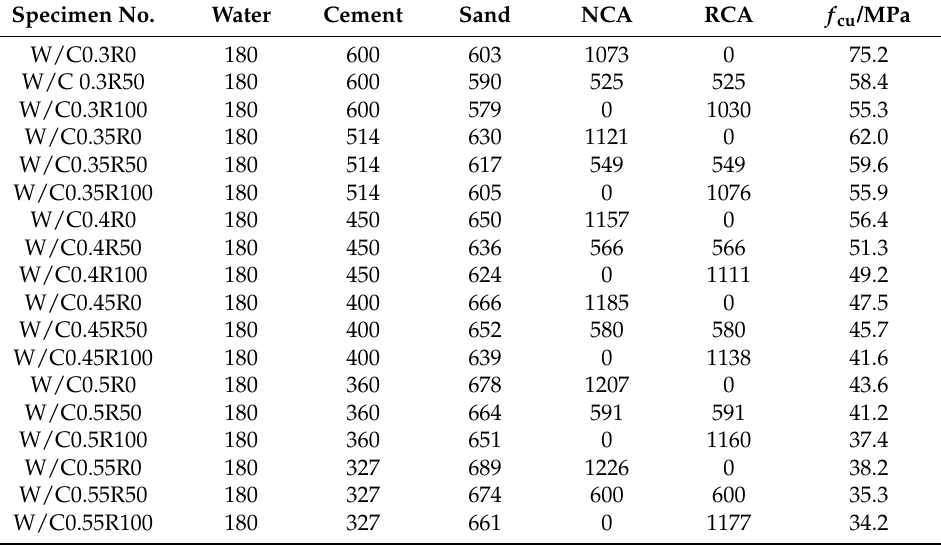
Table 5. Mixture design (kg/m 3 ) and compressive strength of recycled coarse aggregate concrete (RCAC) with different water-cement ratio (W/C).